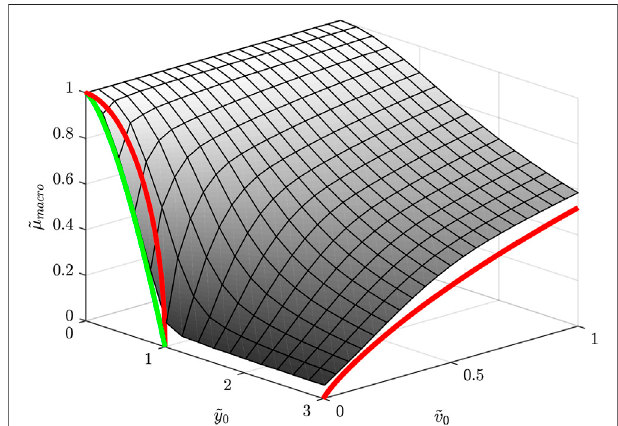
FIGURE2| Dependencyofthemacroscopiccoef fi cientoffrictiononthe dimensionless velocity and oscillation amplitude for transversal oscillations. The smallest value of ~ v 0 is 0.005. Green line represents Eq. (11) , red lines represent Eq. (6) on the right, Eq. (7) on the